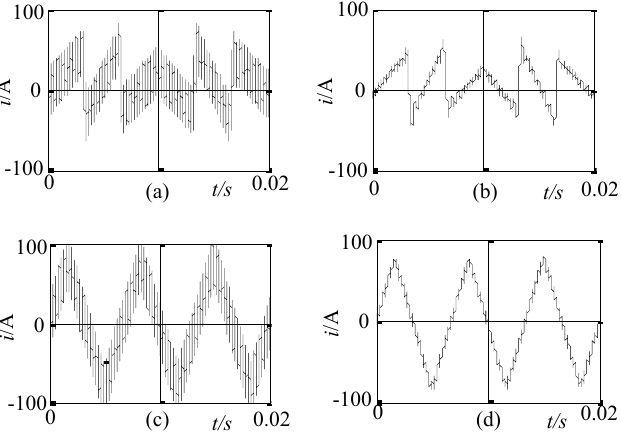
Figure 10. Comparison between converter-side and grid-side current in phases A and N. ( a ) and ( c ) show the current waveforms in the converter side in phases A and N. ( b ) and ( d ) show the current waveforms in the grid side in phases A and N. The figure clearly shows the filtering effect by the proposed 4B-LCL interface. The grid-side current waveform is considerably smoother than that of the converter side.